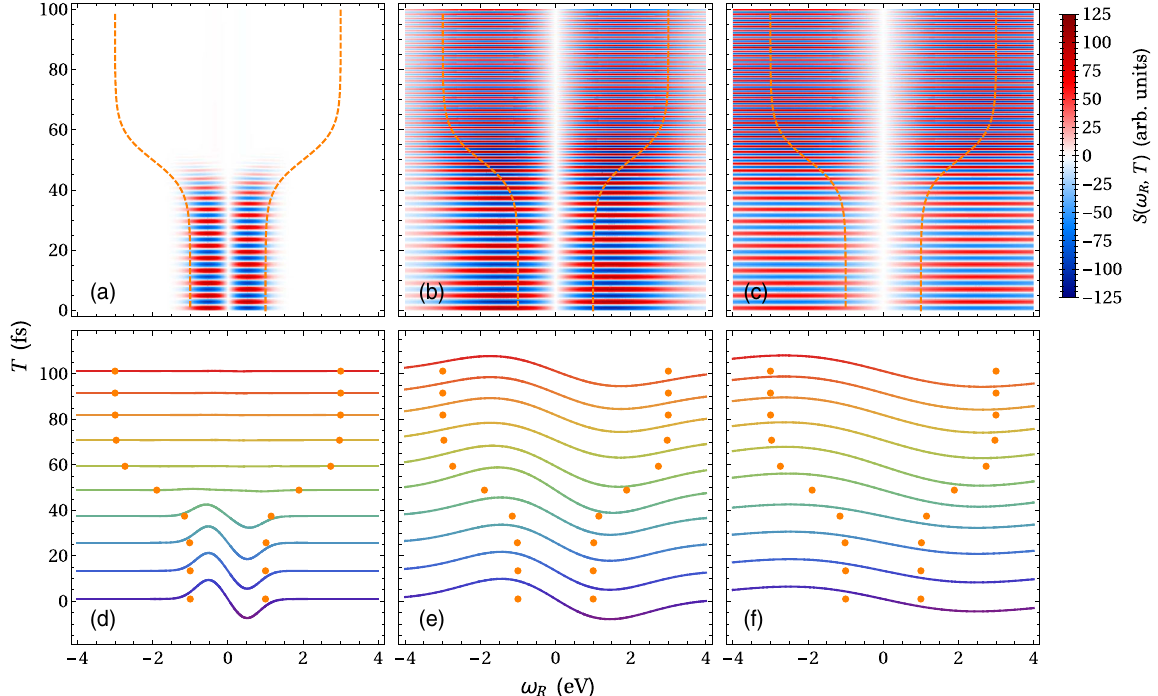
˜ E ð ω Þ of bandwidth